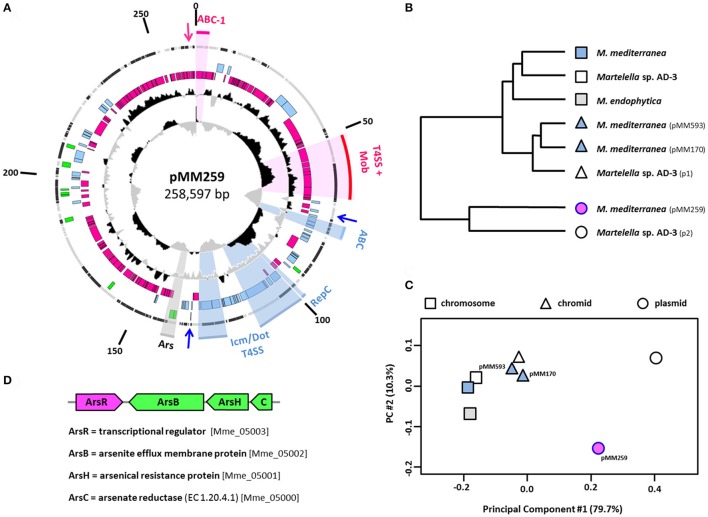
The composite M. mediterranea DSM 17316T plasmid of mixed rhodobacteral/rhizobial ancestry. (A) Circular map of pMM259. Circles represent from inside to outside (1) G+C skew (10,000 bp window); (2) G+C content and deviation from the mean value (1,000 bp window) (3, 4, 5); Coding sequences (CDSs) of Rhodobacterales/Rhizobiales/other origin (pink/blue/green) (6) location on the plus or minus strand (gray/black). The origins of CDSs were determined via best BLASTP hits (E-value < 10−5). RepABC-type replication systems (ABC) and type four secretion systems (T4SS) are accentuated with sectors and labeled with respect to their origin (pink/blue). Arrows indicate the localization of toxin/antitoxin operons. Mob, mobilization module (virD2, virD4 genes); Ars, arsenate-resistance operon. (B,C) Principal component and cluster analysis of relative synonymous codon usage (RSCU) based on all protein-coding sequences from the M. endophytica chromosome (light gray), four M. mediterranea (light blue), and three Martelella sp. AD-3 replicons (white). pMM259 is highlighted in pink. The dendrogram based on a hierarchical cluster analysis of the overall RSCU. Two-dimensional scaling explains 90.0% of the variance. Chromosomes, chromids and plasmids are indicated by squares, triangles and circles, respectively. (D) Structure of the arsenate-resistance operon. Xenologous genes of gammaproteobacterial origin are shown in green.